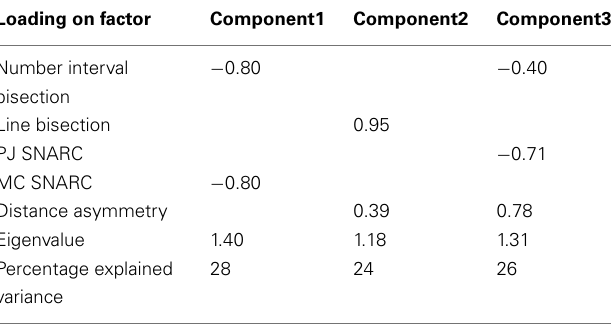
Table 2 | Overview of the three component solution obtained from the